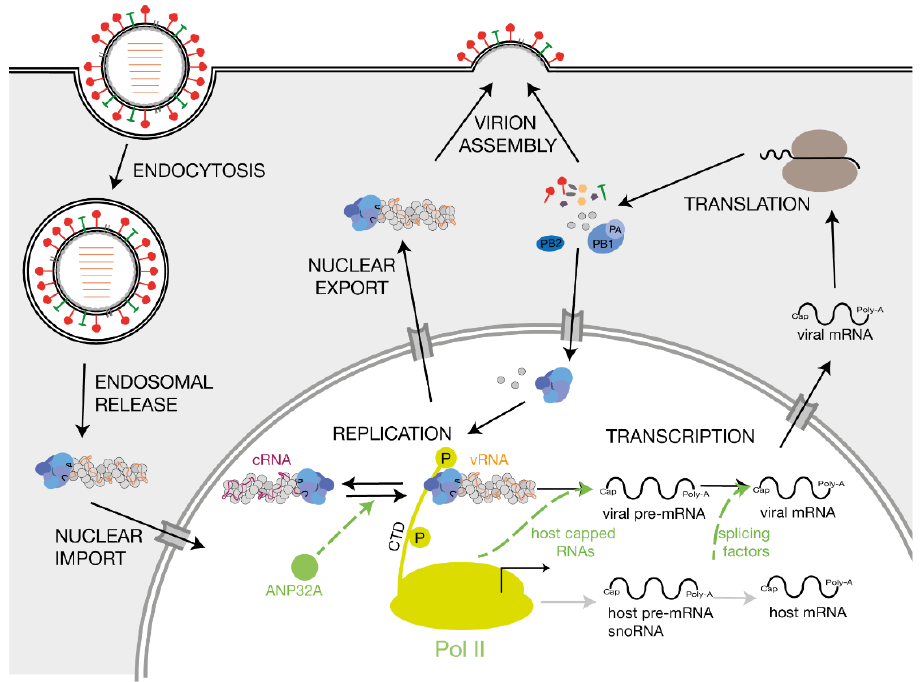
Figure 2. Influenza A virus replication and host factors involved in influenza A virus RNA synthesis. Schematic of IAV replication cycle. Key host factors that play a role in viral RNA synthesis are indicated in green. The green arrows point to the step of the replication cycle that is promoted by the corresponding host factor. The viral proteins PB1, PB2 and polymerase acidic PA are coloured bright blue, dark blue and grey blue, respectively.